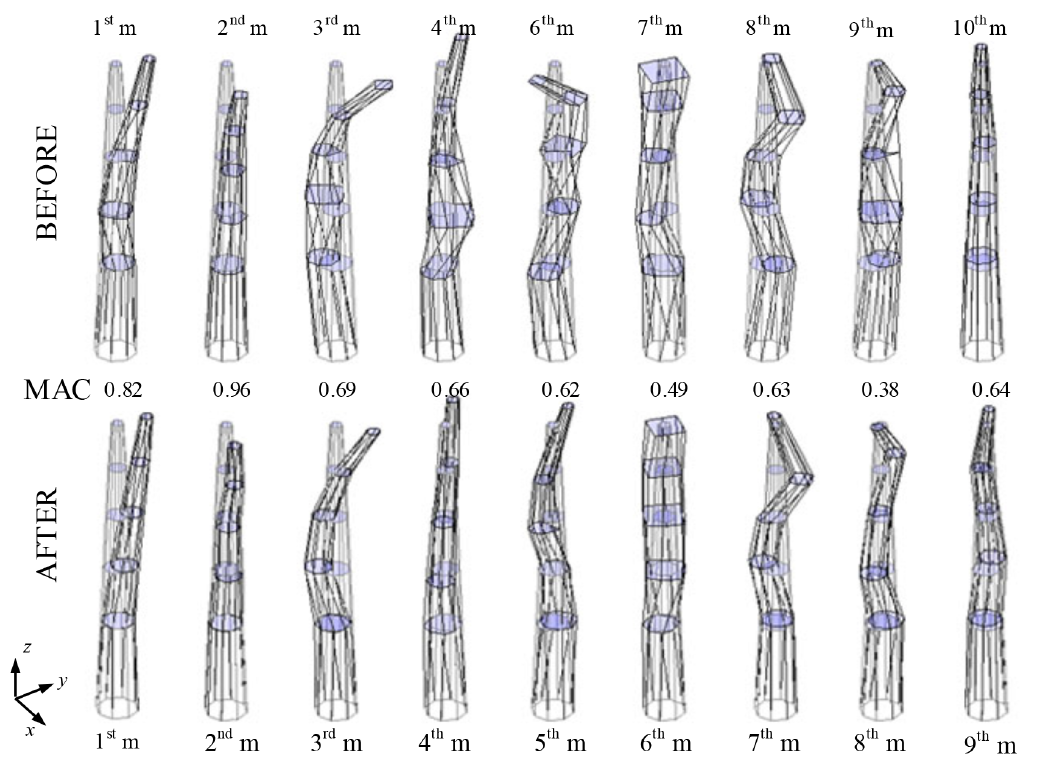
Figure 6. Experimental mode shapes and MAC values before and after the intervention.